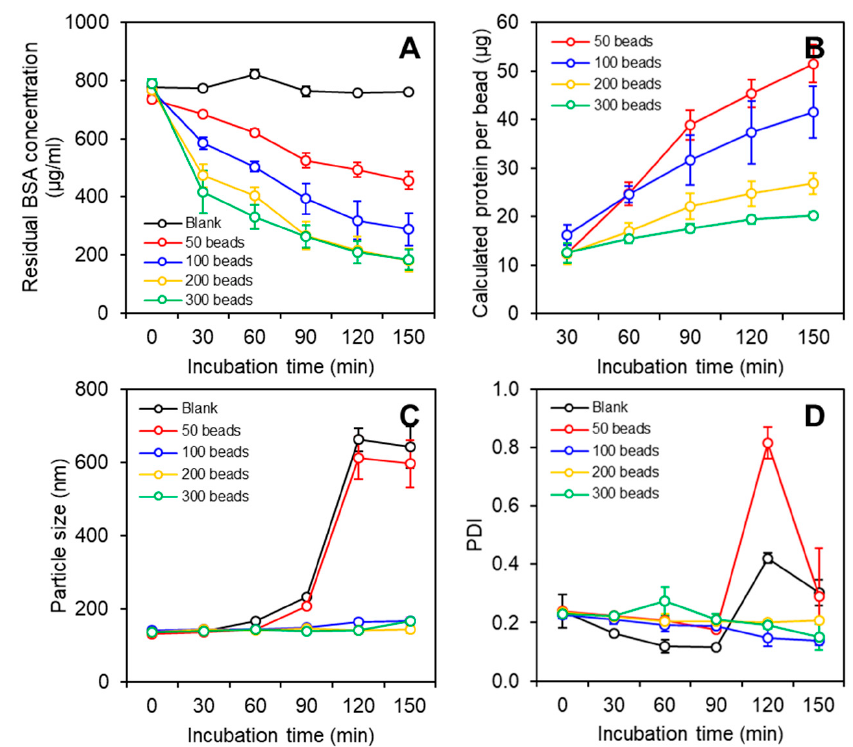
Figure 2. ( A ) Change of protein concentration in the SLPN dispersion during incubation with chitosan beads; ( B ) calculated protein amount per bead during the incubation of SLPN with chitosan beads; particle size ( C ) and polydispersity index (PDI) ( D ) of the SLPN dispersion during incubation with chitosan beads.